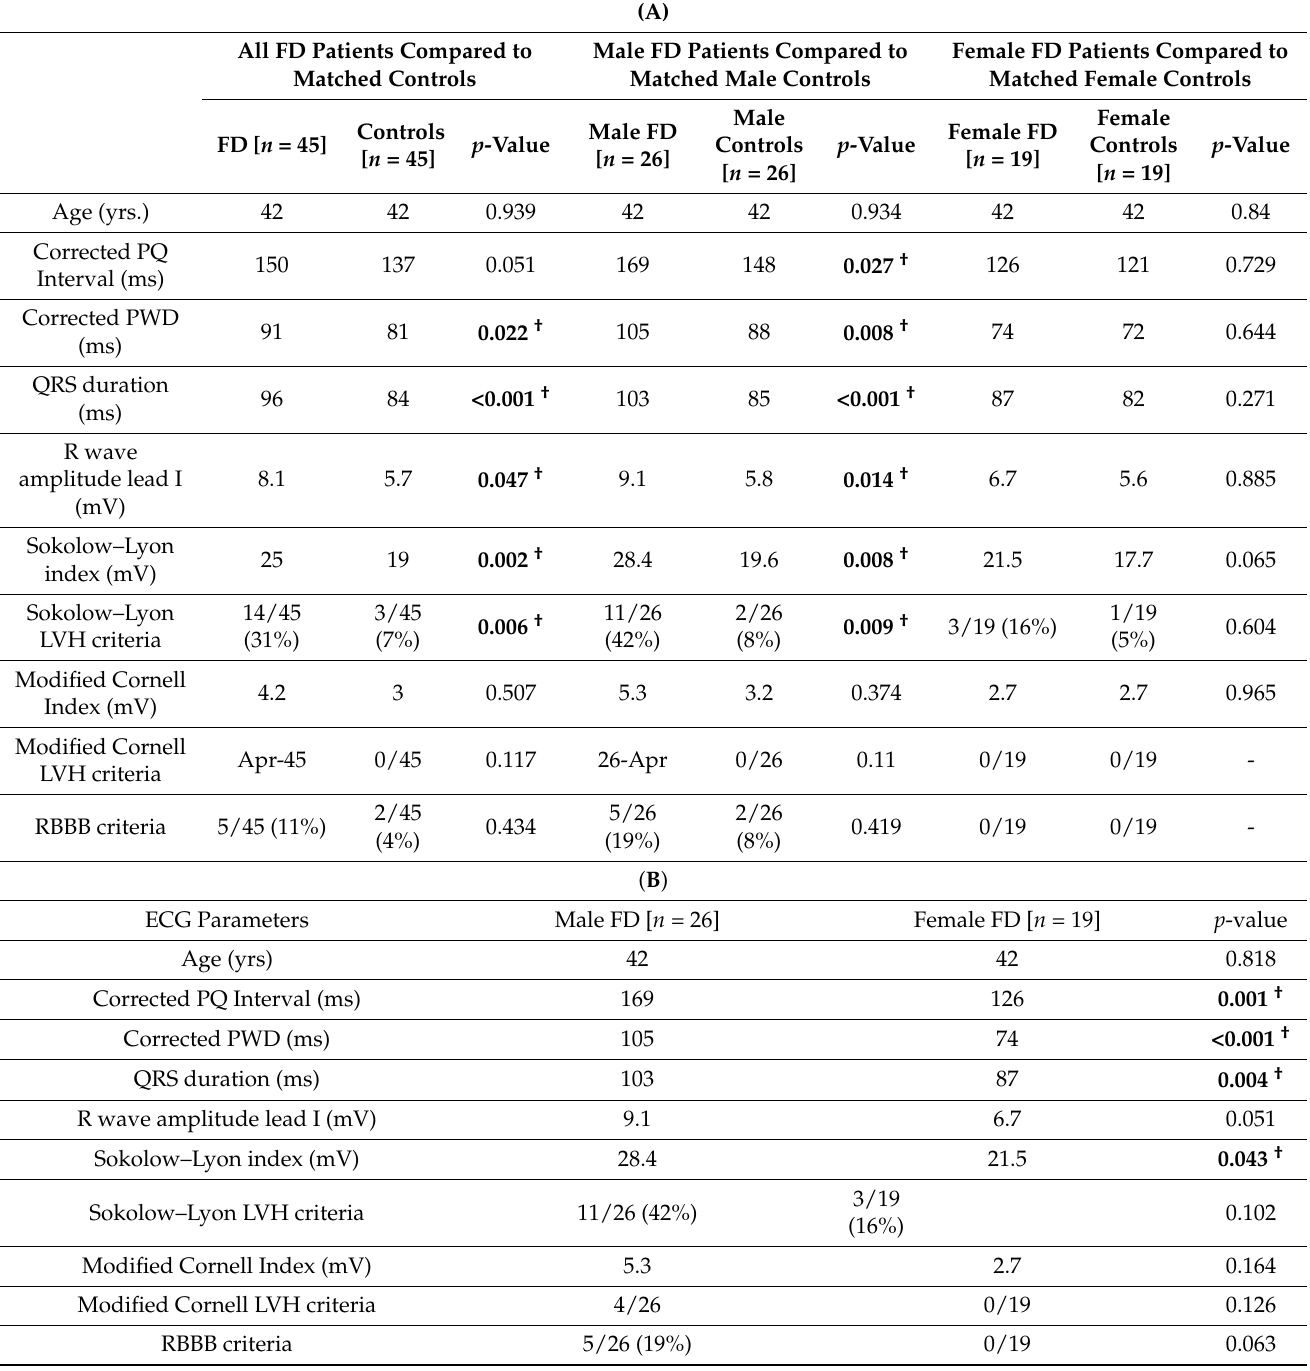
Table 1. ( A ). Electrocardiographic characteristics of FD patients compared to age and gender matched normal controls. ECG parameters assessed are listed in the first column. Comparison is made between FD patients and matched controls; between male FD patients and matched male controls only; and between female FD patients and matched female controls only. ( B ) Comparison between the electrocardiographic characteristics of male FD patients and female FD patients. ECG parameters assessed are listed in the first